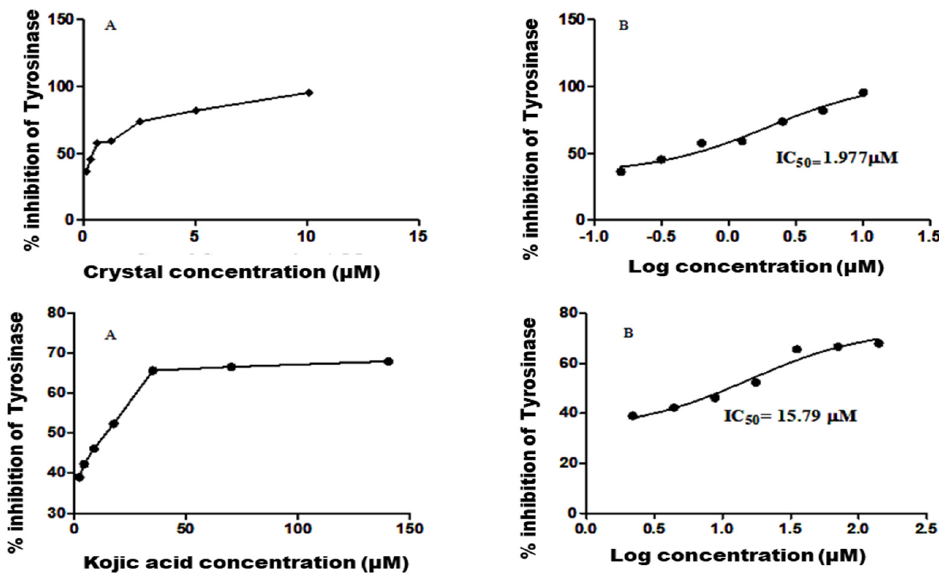
Figure 8. IC 50 values of crystal and reference drug kojic acid were calculated by nonlinear regression using Graphpad prism 5.0. ( A ) Represent the inhibitor concentration versus enzyme activity. ( B ) Represent the Log concentration versus enzyme activity.